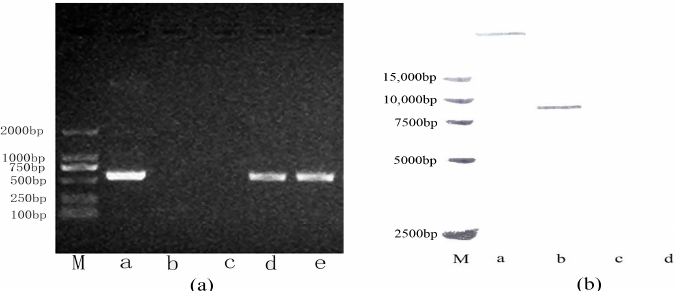
Figure 1. Integration of the oleosin-rhFGF-10 gene following safflower transformation. ( a ) Polymerase chain reactions (PCR) showing that the oleosin-rhFGF-10 gene had been inserted into the genome of transgenic safflowers. Lane M, molecular weight standards, lane a, positive control; lane b, negative control; lane c, blank control; lanes d–e, transgenic safflower lines. The PCR product is approximately 500 bp; ( b ) Southern blot showing a positive hybridization signal only for the positive control, lane a, and one of two transgenic safflower lines, lanes b–c. The wild type safflower, lane d, was negative. The number of oleosin-rhFGF-10 gene copies in the positive transgenic line was one.